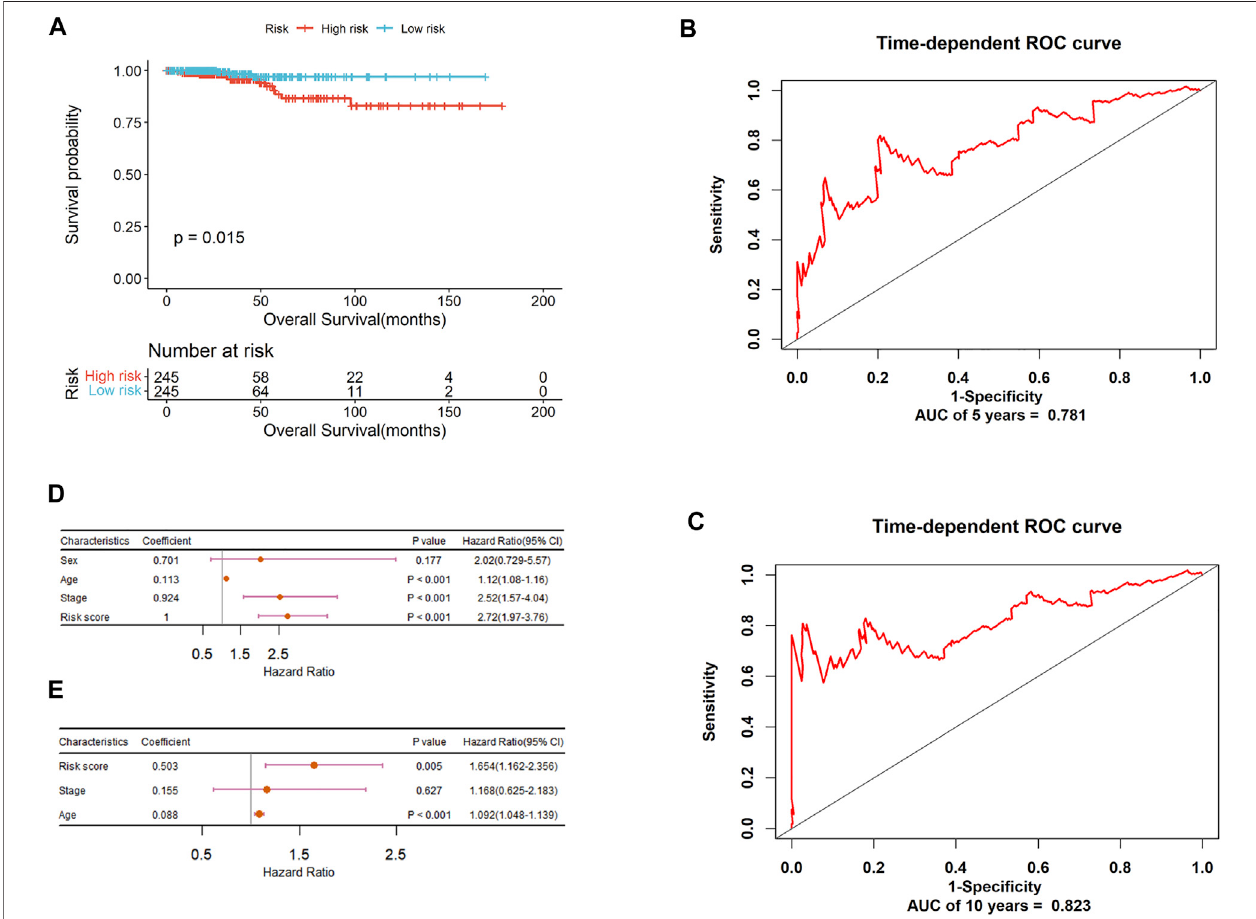
FIGURE 7 | The prognostic signi fi cance of PTC-mi1m4 signature to predict OS of PTC patients. (A) Kaplan-Meier curve analysis for OS. (B) ROC validation of prognostic value of PTC-mi1m4 signature for predicting 5-years survival of PTC patients. (C) ROC validation of prognostic value of PTC-mi1m4 signature for predicting 10-years survival of PTC patients. (D) Forest plot summary of univariable analysis of sex, age, stage, and risk score. (E) Forest plot summary of multivariable analysis of age, stage, and risk score.